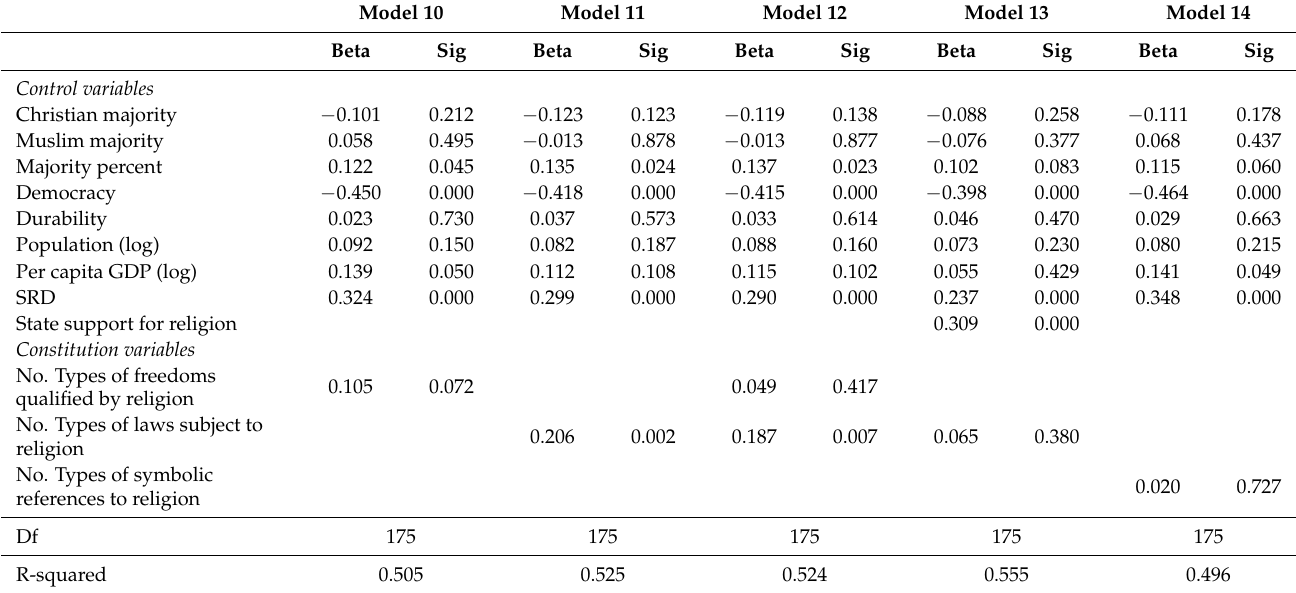
Table 8. OLS regressions predicting the influence of freedoms and laws subject to religion and symbolic mentions of religion on